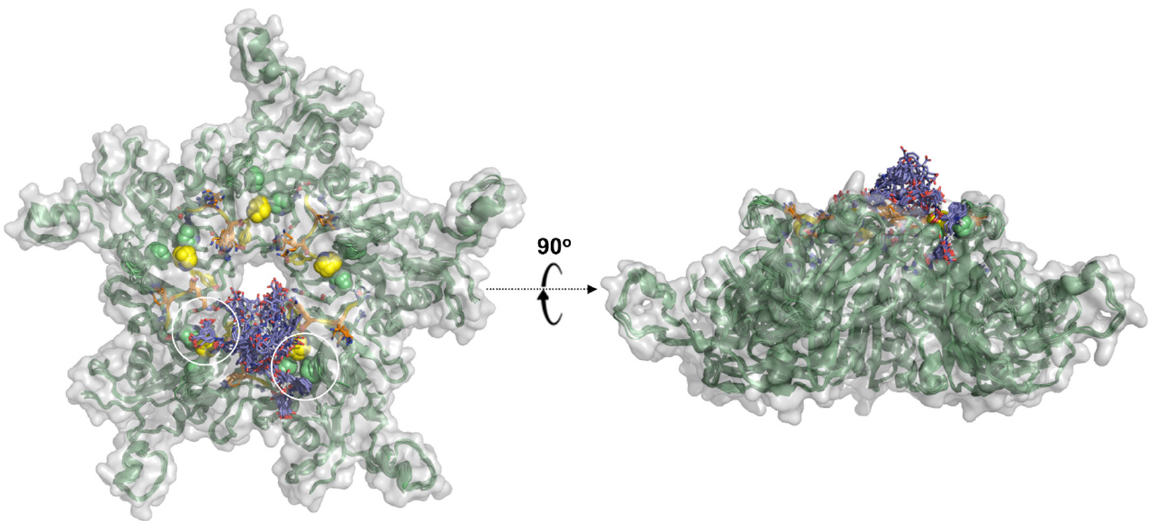
Figure 4. Molecular model of one EV-A71 VP1 pentamer in complex with a single 23 ( AL-534 ) molecule. Top and side views of ten overlaid ensembles are displayed that were generated from the molecular dynamics simulation lasting 300 ns and subsequent simulated annealing and energy minimization. The protein is shown as a green ribbon enveloped by a semitransparent gray surface to highlight the crevices. For reference, the side chains C atoms of the 241 Ser-Pro 246 stretch in the H–I loop are colored in yellow, except for Lys242 and Lys244, which are colored in orange. The entry inhibitor is displayed as sticks with C atoms colored in violet. Note how one of the legs of 23 ( AL-534 ) binds permanently at the interface between two VP1 subunits—as shown in Figure 3—while the others extend away from the protruding central pentaerythritol-based scaffold and make additional crucial interactions with residues lining the pore and neighboring subunits. Significantly, in the equilibrated complexes, one of the isophthalic acid rings from another leg stacks on Pro246 (yellow spheres) and its carboxylic groups form ionic bridges with the invariable Lys244 (top view, circled area on the left), whereas the Trp unit at the subunit interface preferentially stacks on Pro96 (top view, circled area on the right).